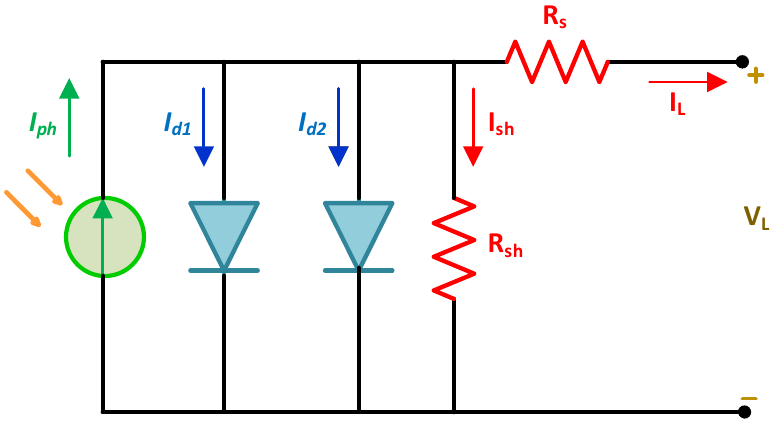
Figure 2. DDM mathematical model.